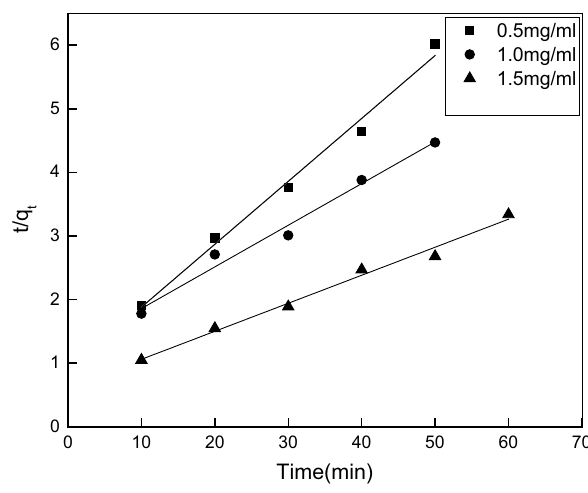
Fig. 11 Quasi-second-order kinetic fitting